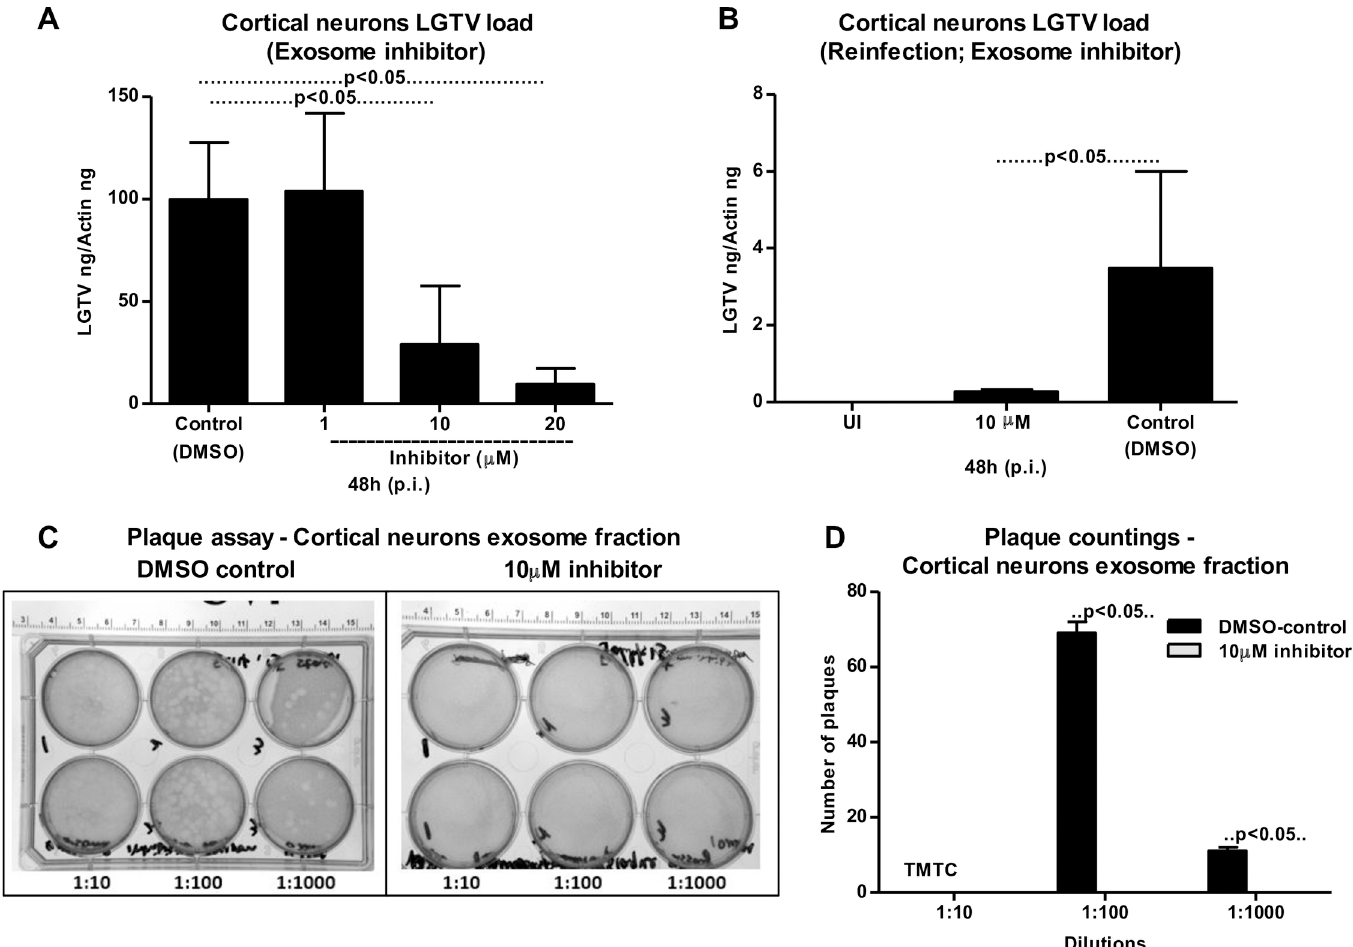
Fig 7. Treatment of primary cultures of cortical neurons with exosome inhibitor affectsLGTV infection. (A) 1 x 10 5 cortical neuronalcells was infected with LGTV (4 MOI). QRT-PCR analysisshowinglevels of LGTV in exosomesisolated from cortical neuronalcells at 48 h p.i. in the presence of exosome- inhibitorat different concentrations (1, 10, 20 μ M). Cortical neuronalcells were pre-treatedwith exosomesinhibitor for 4 h followedby infection with LGTV. Exosomes isolatedfrom cortical neuronalcells treated with DMSO served as control. (B) Levels of LGTV in fresh cortical neuronalcells at 48 h p.i., infected by treatment with exosomes (20 μ l) isolated from control or inhibitor-treated mouse cortical neuronal cells is shown. UI indicatesuninfectedcells that serve as control. LGTV transcript levels were normalized to mouse beta-actin. (C) Plaqueassays performed with different dilutions(1:10, 1:100, 1:1000) of exosomes fractions isolated from control DMSO-treated or inhibitor-treated cortical neuronalcells are shown. Ruler at the top determines the scale for the plaqueassay. Representative images are shown from two independent experiments. (D) Quantitative assessment of the number of plaques from (C) is shown. TMTC indicates“too many to count”. P value determinedby Student’s t test is shown. Representative data in A and B is shownfrom three independentexperiments.